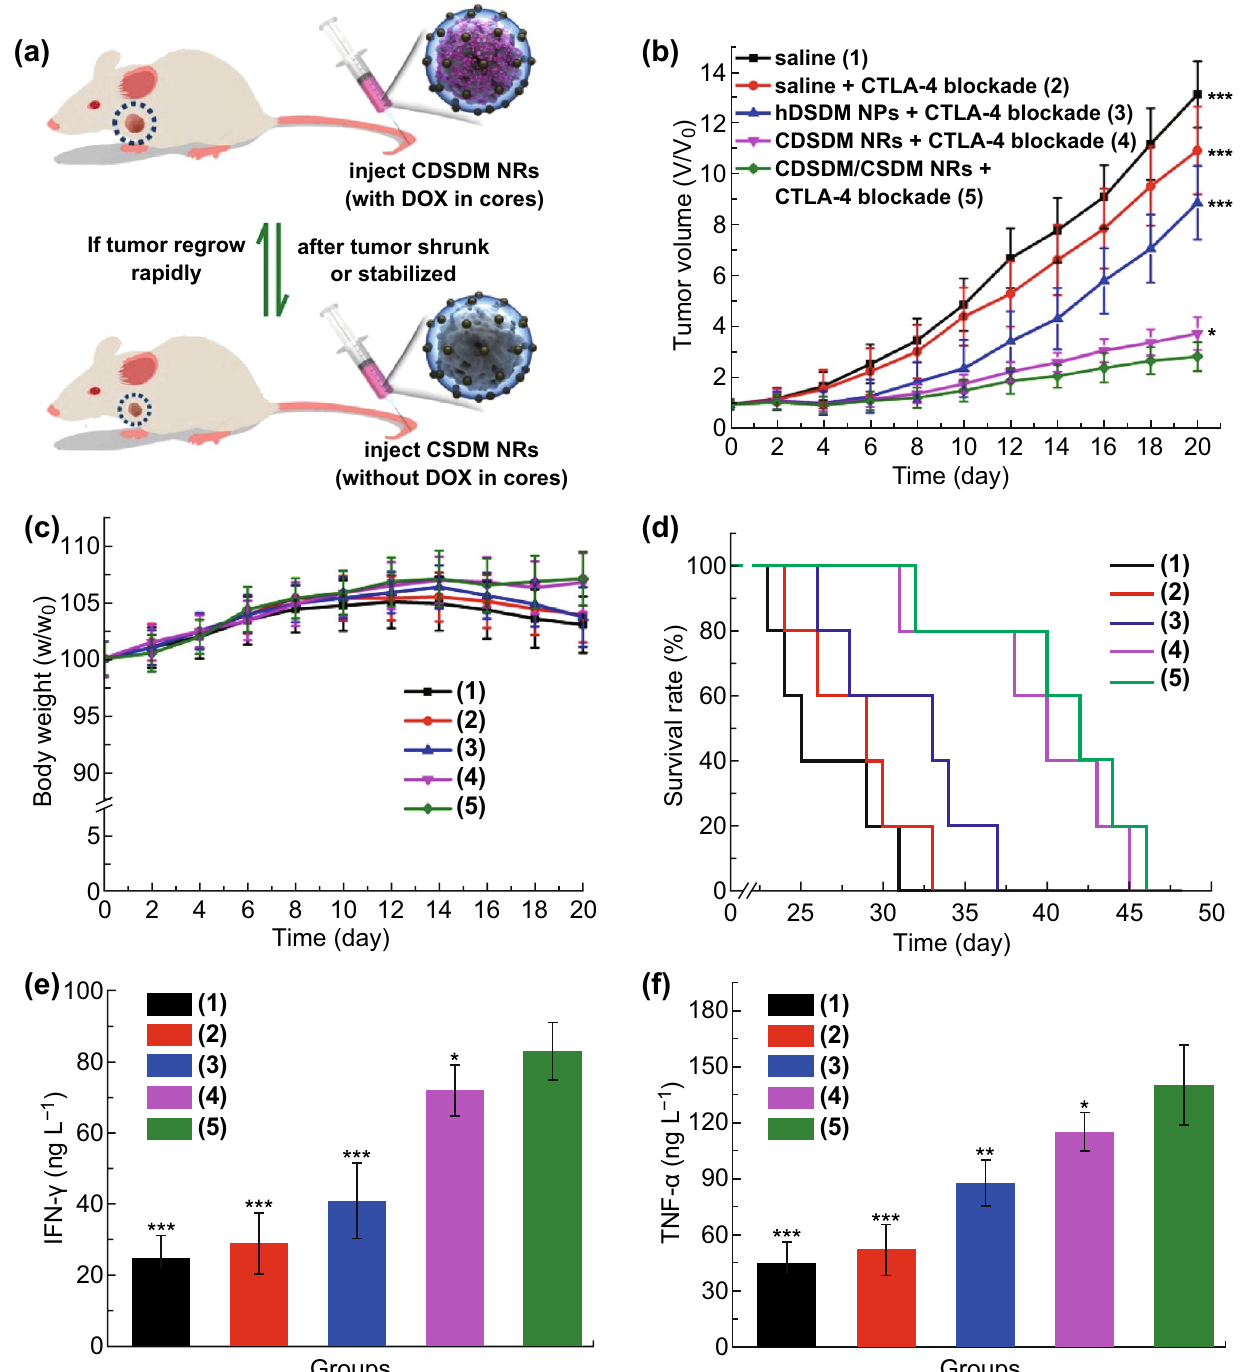
Fig. 4 a Illustration of adaptive administration of CDSDM NRs and CSDM NRs. b Relative tumor volumes and c body weights of B16F10 tumor‑bearing mice received with different treatments during the treatment period. d Survival rate of mice in each group during and after treat‑ ment. Serum levels of e IFN‑γ and f TNF‑α detected after 8 days of different treatments. * P < 0.05; ** P < 0.01; *** P < 0.001 versus Group